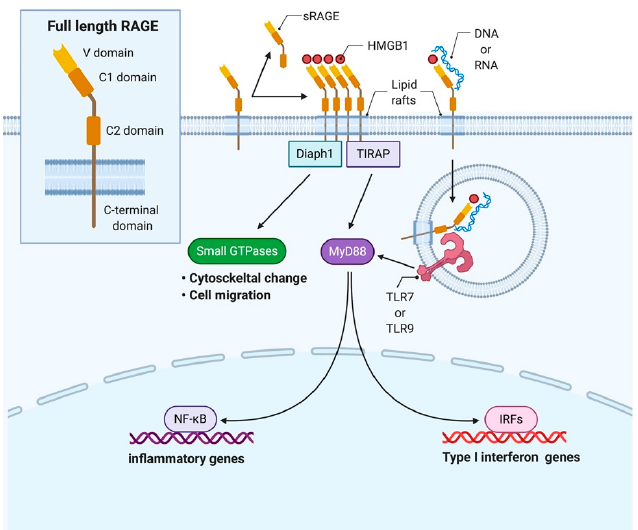
Figure 2. RAGE structure and signaling pathway. The receptor for advanced glycation endproducts (RAGE) has three extracellular immunoglobulin-like domains (V, C1, and C2), a single transmem-